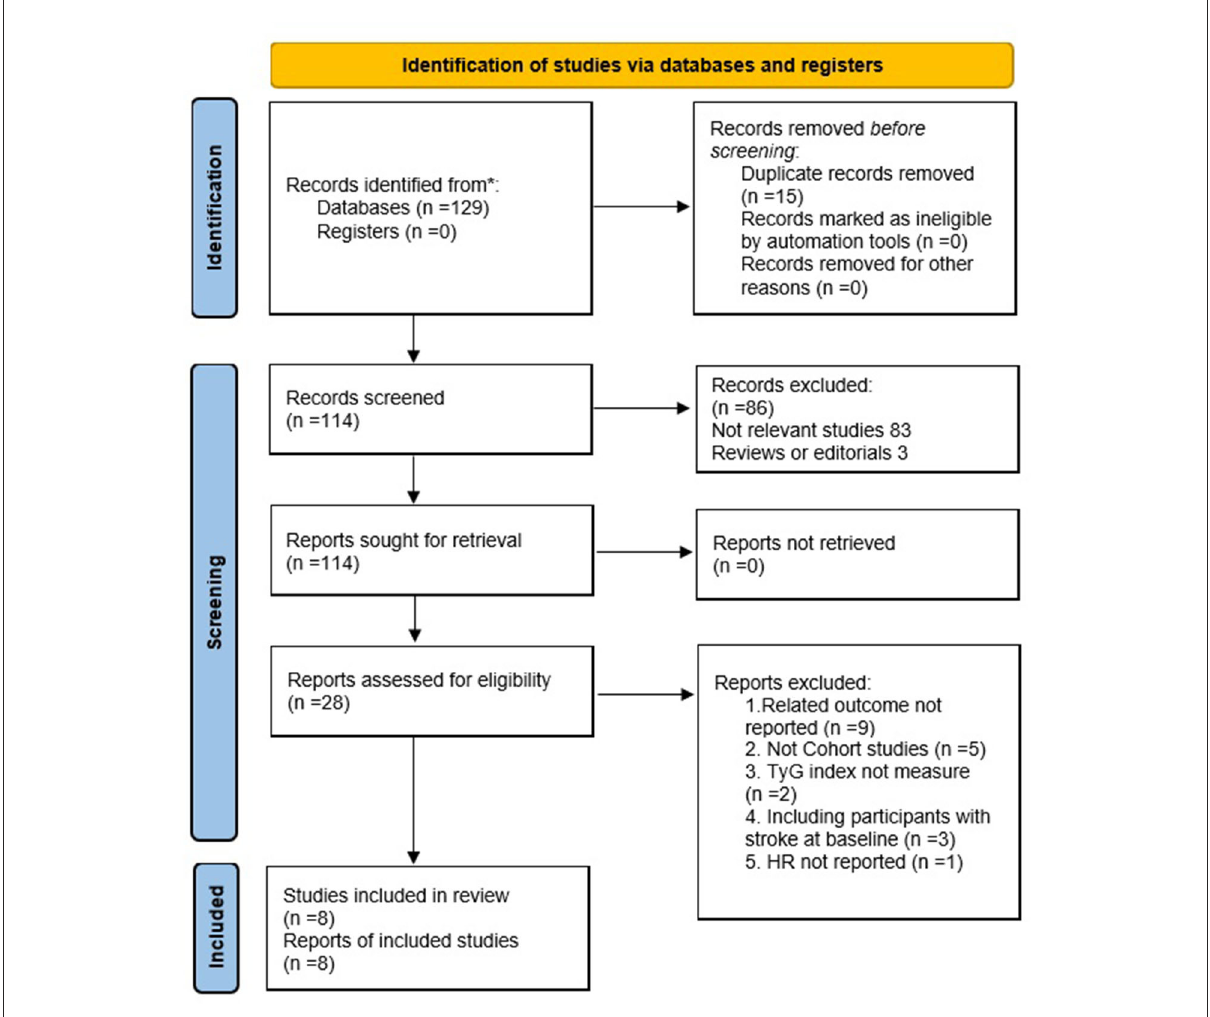
FIGURE1 Flowchart of the databases search and study